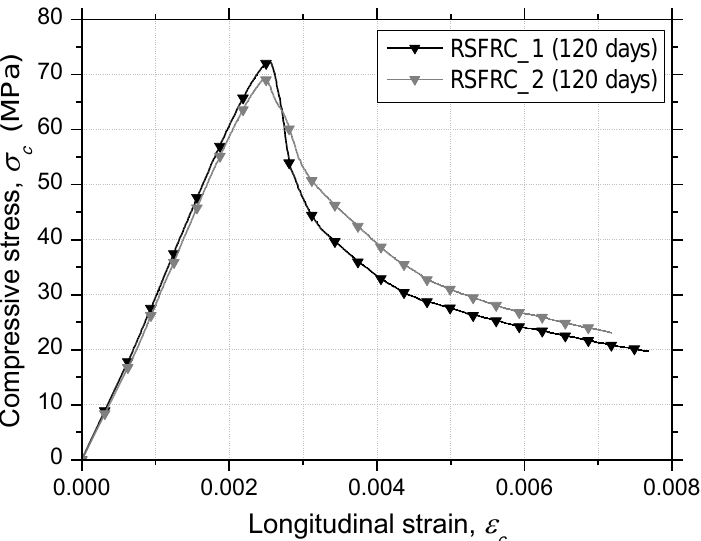
Figure 4. Average compressive stress–longitudinal strain curves obtained in compression tests of RSFRC_1 and RSFRC_2 batches (120 days). Table 3. Average results (and coefficients of variation (CoV) of compression tests.